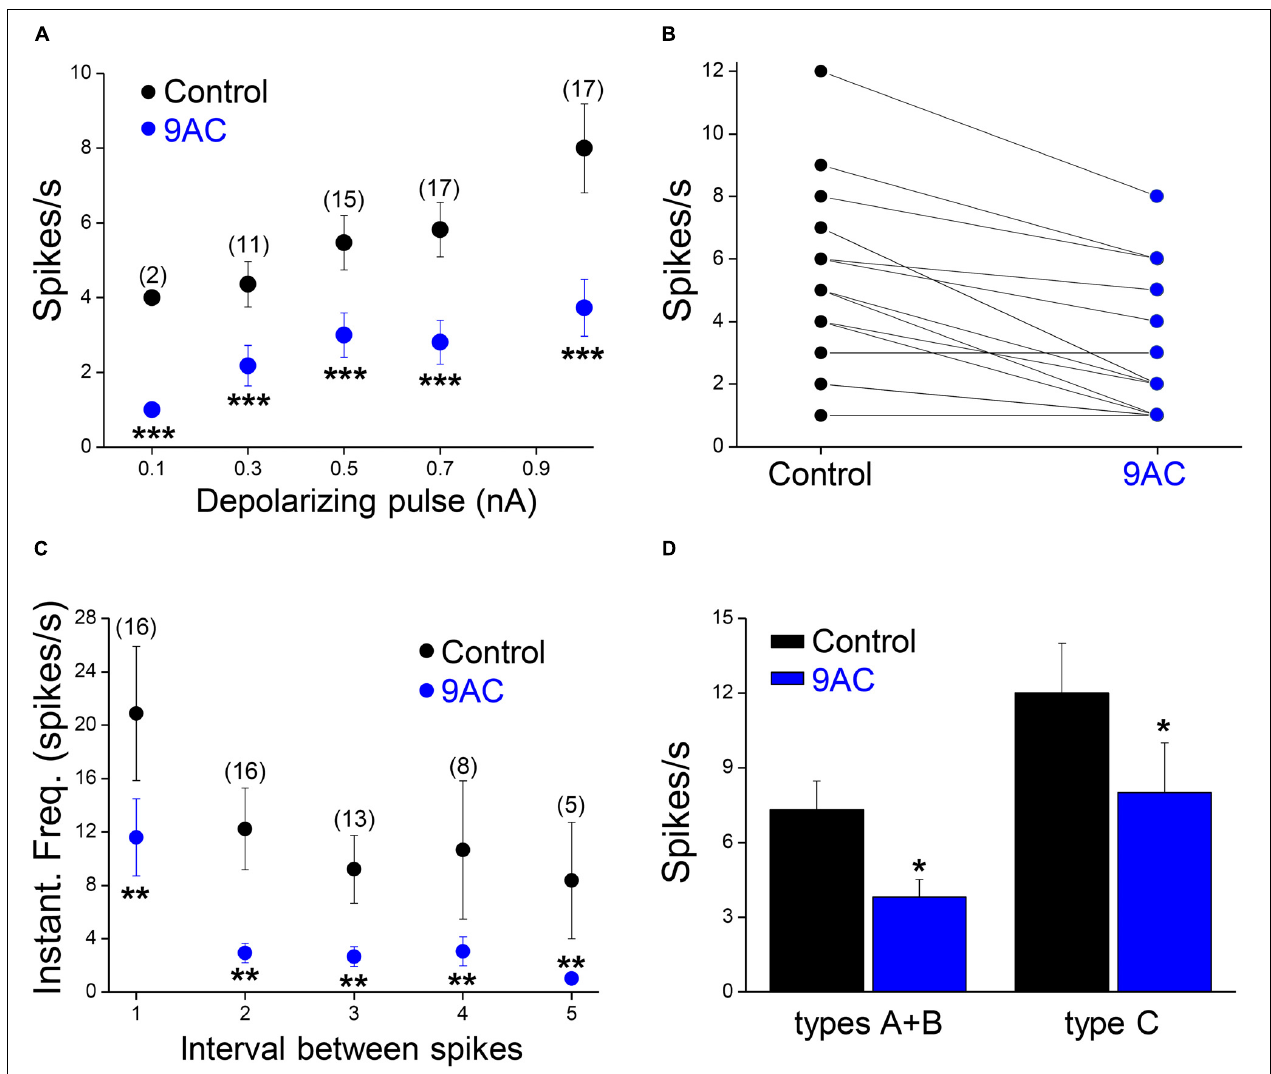
FIGURE 3 | The chloride channel blocker 9AC reduces firing frequency and instantaneous frequency in almost all sympathetic neurons. (A) The reduction in firing frequency was observed for all the amplitudes of the depolarizing pulse used (black circles for control solution and blue circles for 2 mM 9AC solution). Only cells firing two or more spikes in the control were considered (numbers in brackets). (B) The number of APs elicited is larger in control than in 9AC in the majority of cases (15 out of 18) with 0.5 nA depolarizing pulses. (C) The instantaneous frequency of spikes was reduced for all of the five first intervals between consecutive spikes studied with depolarizations of 1.0 nA. Symbols are the same as in A . The number of cells studied in each case is shown in brackets. (D) Effects of CaCC blockade with 9AC on firing frequency separately in cells with (types A and B) and without (type C) ADP for 1.0 nA depolarizing pulses. Paired t -test: ∗∗ P < 0.01; ∗∗∗ P < 0.001 (A,C) and Student’s t -test: ∗ P < 0.05 (D)